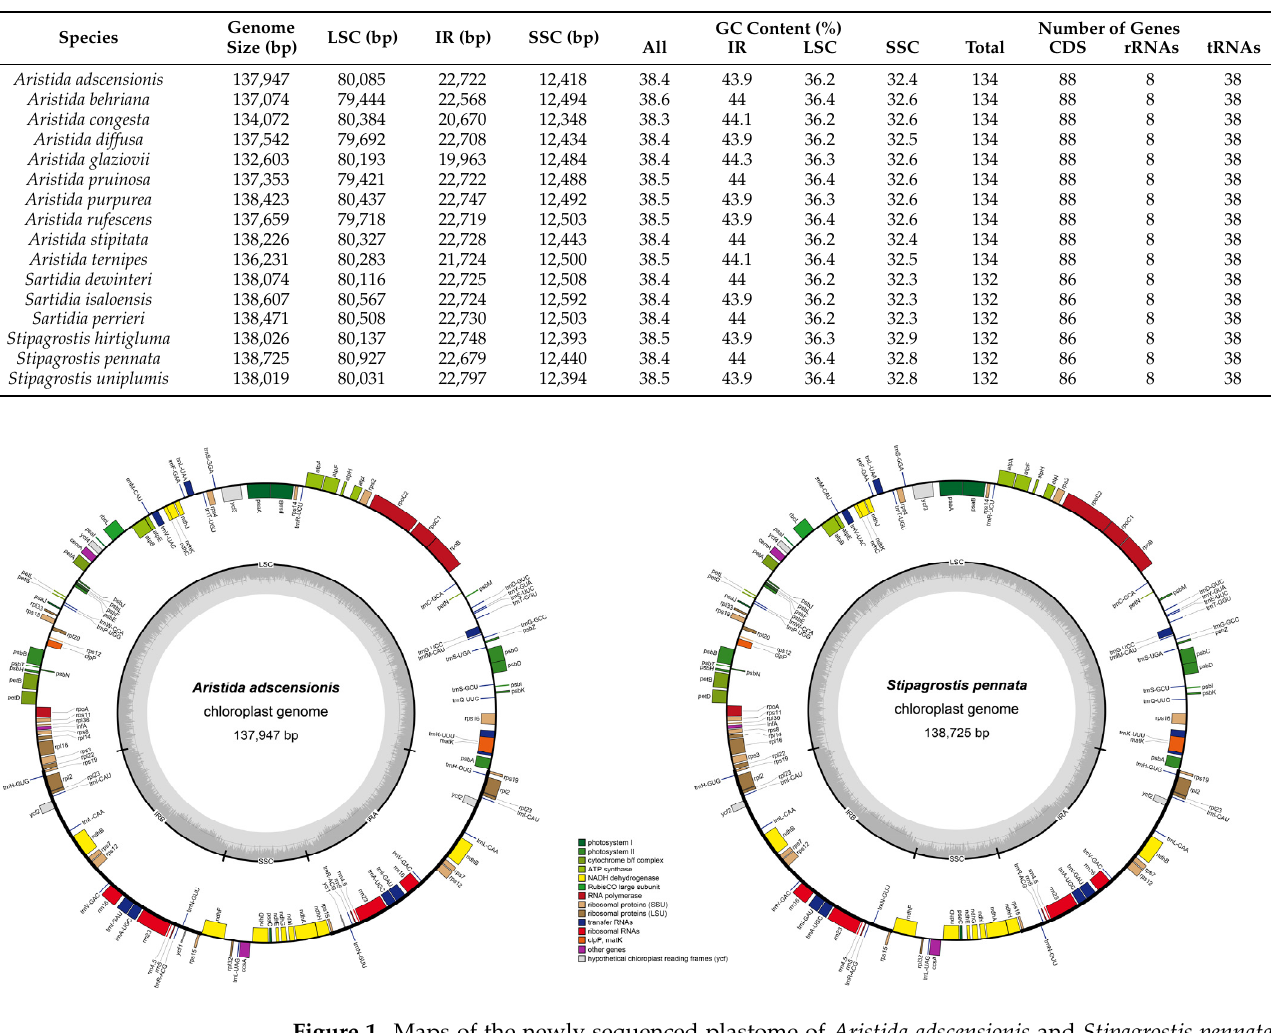
Table 2. Plastome characteristics of 16 Aristidoideae species.